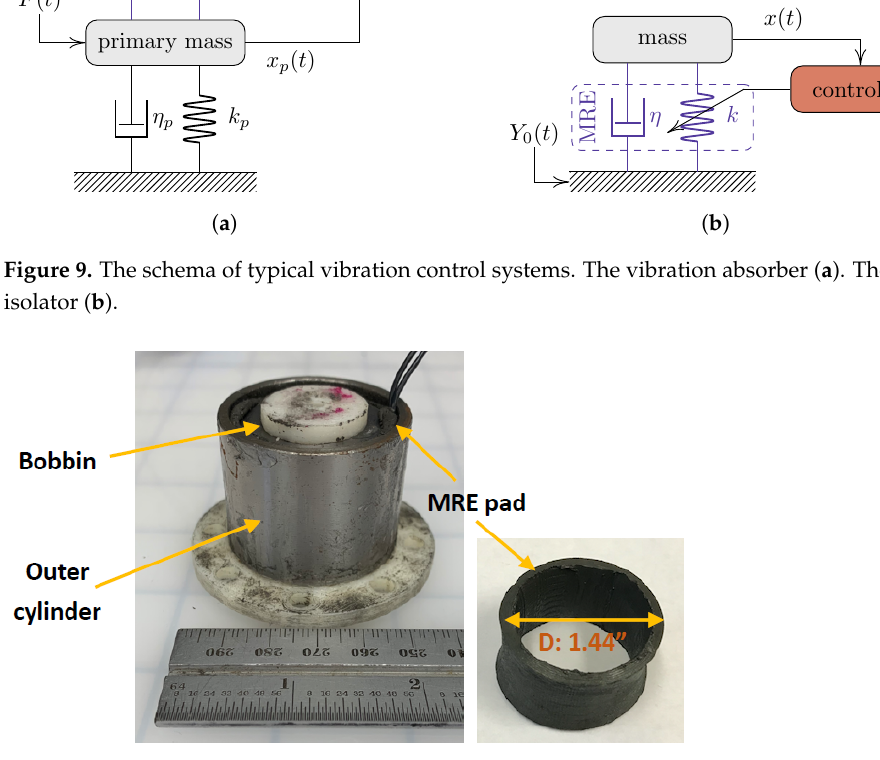
Figure 10. The example of a vibration absorber designed for working in the high-frequency range (source: